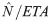
Jaguar density estimates at four sites in Yasuní Biosphere Reserve.Sites are arranged from least accessible to most accessible. Error bars correspond to SD and SE for Bayesian-SECR and N^/ETA methods respectively.